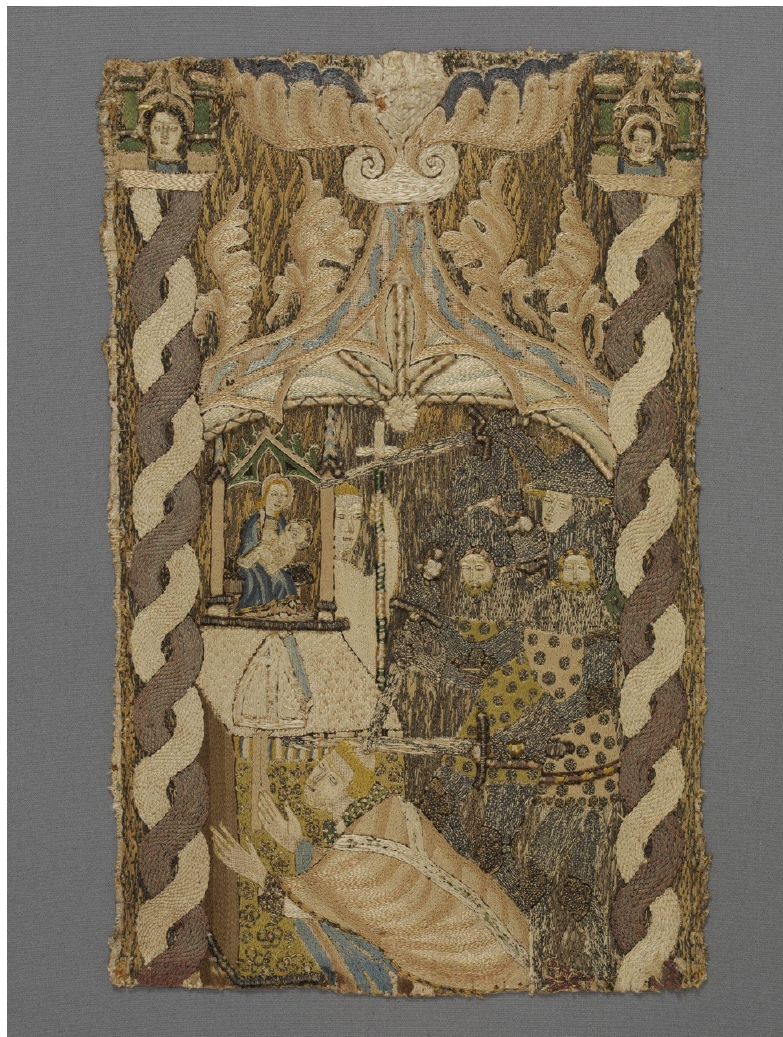
Figure 13. Fragment of orphrey, Becket’s assassination, ca. 1380–1410. London, Victoria and Albert Museum, England. © Victoria and Albert Museum, London.